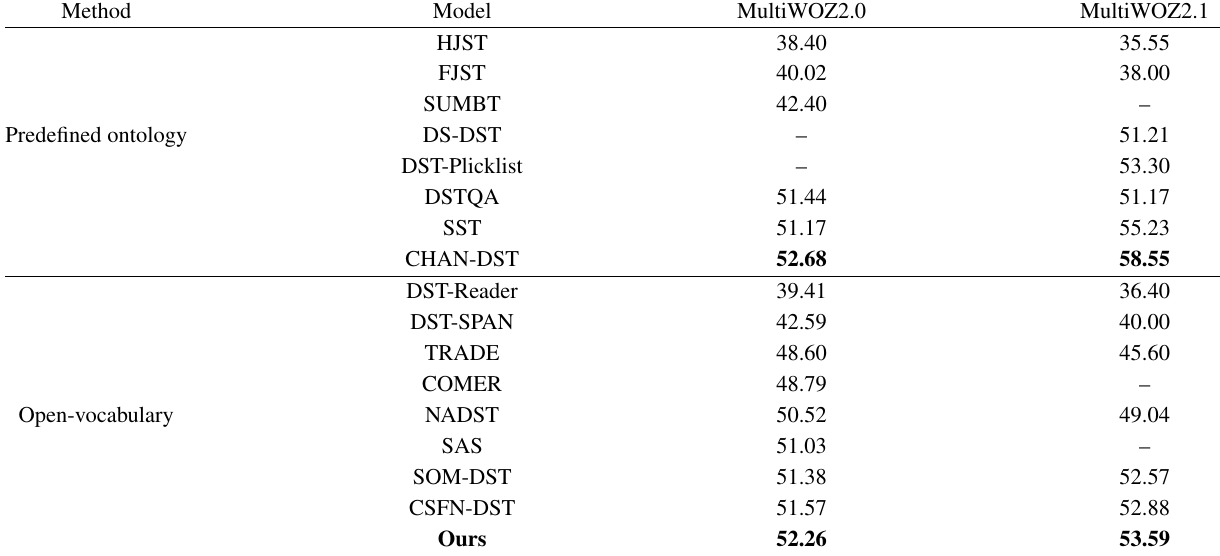
Table 3 Joint goal accuracy on MultiWOZ.